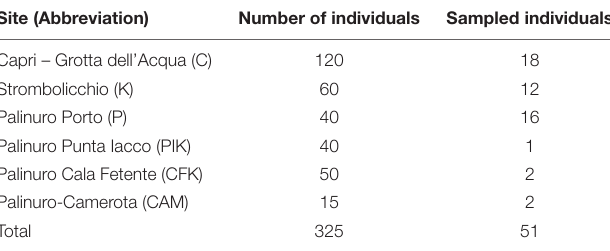
TABLE 1 | Sampling sites of Eokochia saxicola (abbreviation in